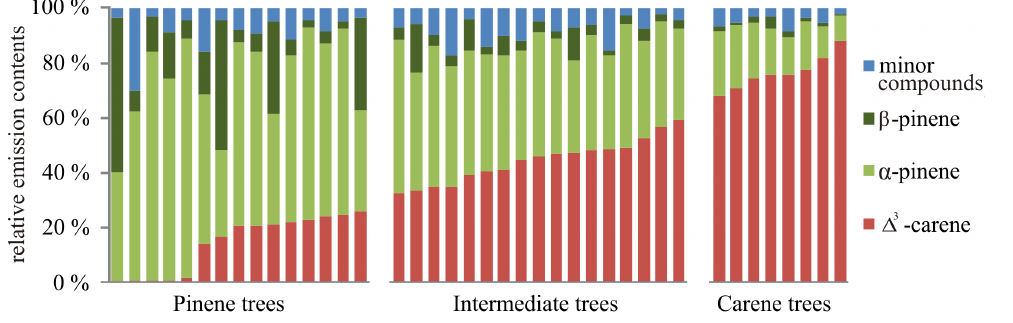
Fig. 5. Relative emission contents of individual trees, clustered as Pinene ( n = 15), Intermediate ( n = 17) and Carene trees ( n = 8). Clustering Figure 6. 849 conducted with the major emitted compounds (type I clustering). 850